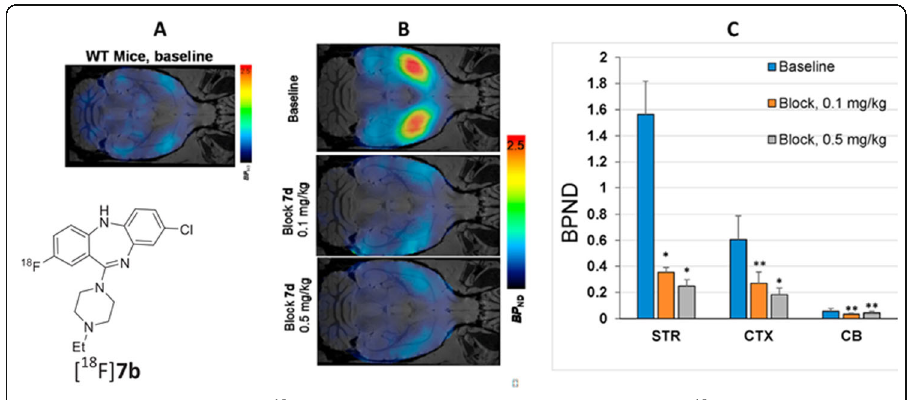
Fig. 5 Panel a : Transverse PET-[ 18 F] 7b of wild-type mouse; Panel b : Transverse PET-[ 18 F] 7b images of tansgenic mice expressing hM3Dq (baseline and dose-escalation blocking); Panel C: Brain regional binding potential (BP ND ) values in baseline and dose-escalation blocking PET scans with [ 18 F]7b in transgenic mice expressing hM3Dq. Abbreviation: STR = striatum; CTX = cortex; CB = cerebellum. Blocker - 7d . Statistical analysis: comparison of baseline versus blocking in the same region. * P <0.05: ** P